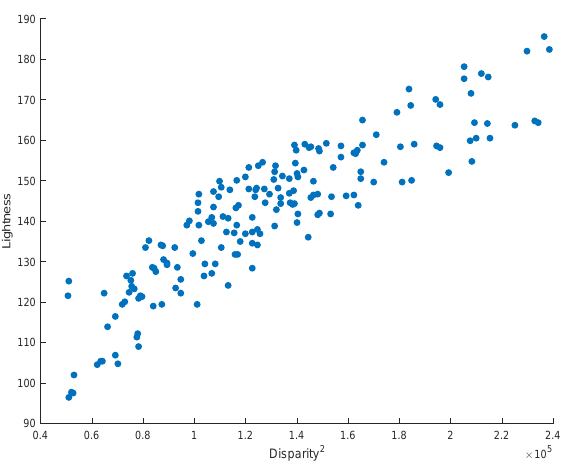
Figure 6. A subset of matched points squared disparity plotted against average pixel lightness.